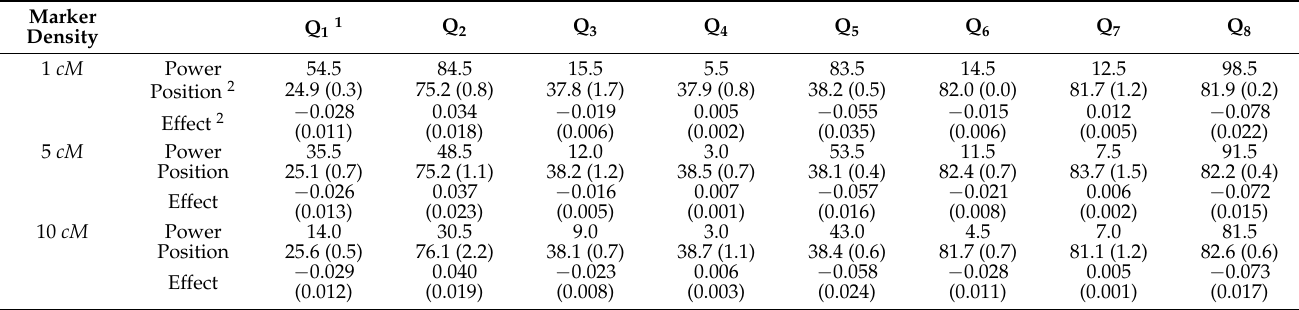
Table 4. Statistical powers and estimated QTL parameters (standard deviations) calculated with the LAASO-RRM method in